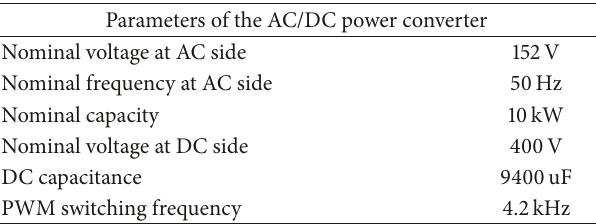
Table 2: Specifications of the AC/DC power